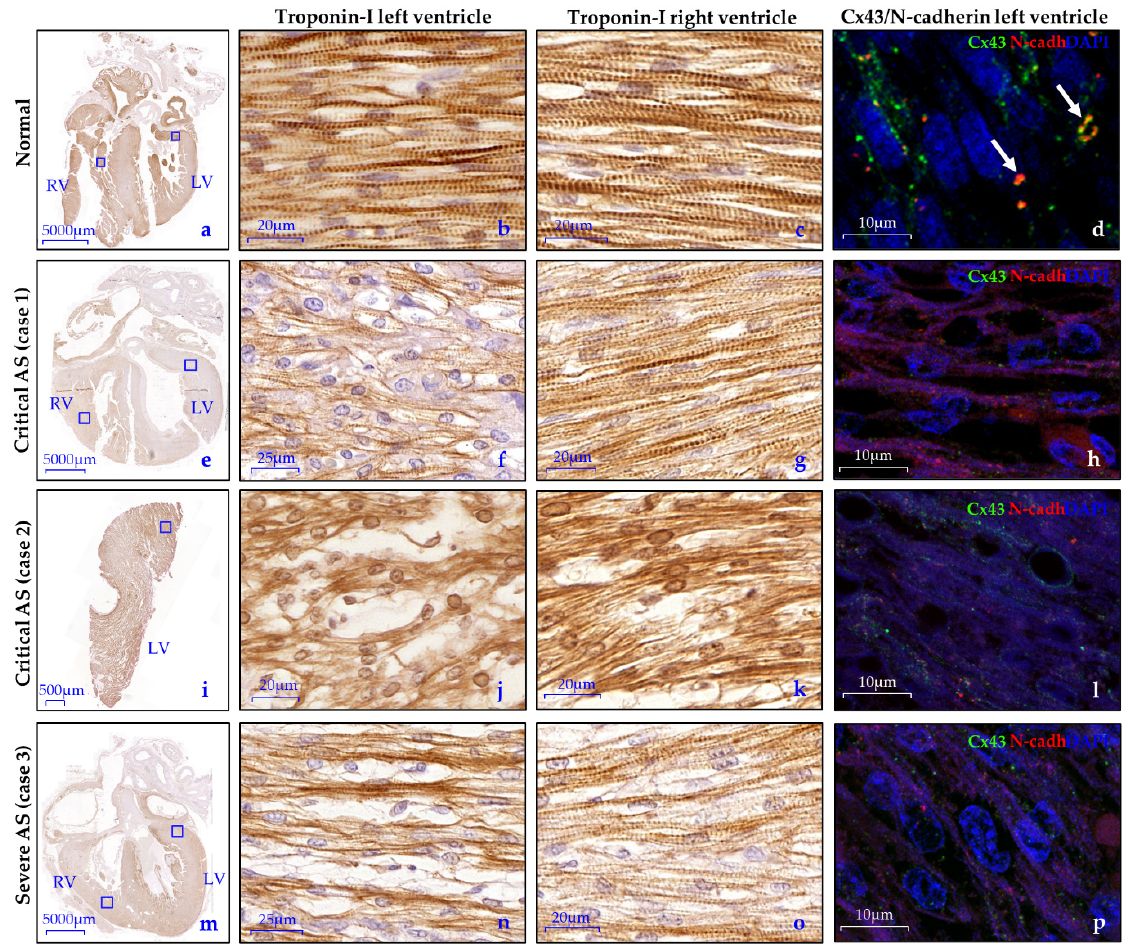
Figure 3. Disturbed alignment and altered Cx43/N-cadherin expression of the cardiomyocytes in fetal aortic stenosis. ( a – c ) In normal hearts, troponin-I staining shows an organized cardiomyocyte network with a proper banded pattern in the cardiomyocytes of both the LV and RV. ( d ) Cx43 (green) and N-cadherin (red) is found as a diffuse pattern in the cytoplasm as well as at the lateral borders of the cardiomyocytes, illustrating the presence of gap and adherence junctions. Some early intercalated disks are present, mostly expressing N-cadherin only but co-expression of N-cadherin and Cx43 is also seen in the intercalated disks (white arrows); ( e – p ) All AS hearts showed contrary findings; ( f , j , n ) The cardiomyocyte organization is disturbed in the LV with an increased amount of extracellular matrix, most apparent in case 1 and 2; ( h , l , p ) Cx43 and N-cadherin expression is markedly decreased and shows only a very scattered pattern in the cytoplasm with barely any lateralization; ( g , k , o ) The RVs of all specimens show regions with normal cardiomyocyte organization but also with mildly disturbed alignment. Negative controls are depicted in Supplementary Figure S1. Cx43, Connexin-43; N -cadh, N- cadherin.